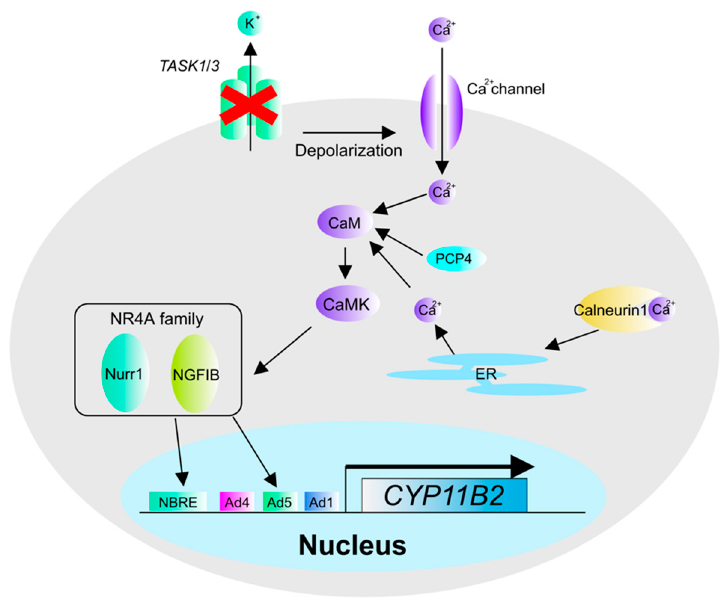
Figure 4. Calcium signaling-related factors in APA. Calcium signaling-related factors that have been implicated in the pathogenesis of APA include the potassium channels TASK, PCP4, and Calneurin1. TASK is functionally defective due to genetic mutations that cause depolarization. PCP4 is a factor that activates CaM function. Calneurin1 is a protein that binds intracellular calcium ions and transports them to the ER, where they enhance calcium signaling during